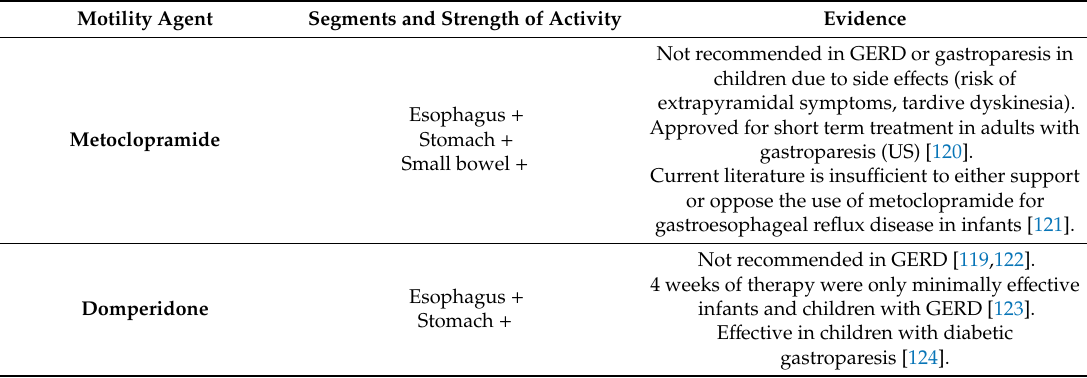
Figure 1. Distribution of the motility-related receptors in the gastrointestinal tract [67]. Table 4. Current evidence for the use of prokinetics in foregut dysmotility in children